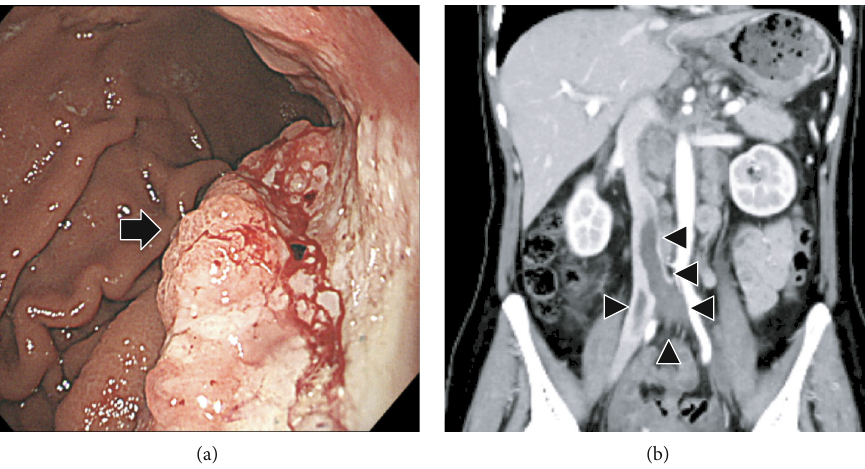
Figure 2: (a) Gastroscopy showing elevated lesions with bleeding in the body of the stomach (arrow). (b) Whole-body CT showing a large thrombus extending from the bilateral common iliac veins to the inferior vena cava (arrowhead).